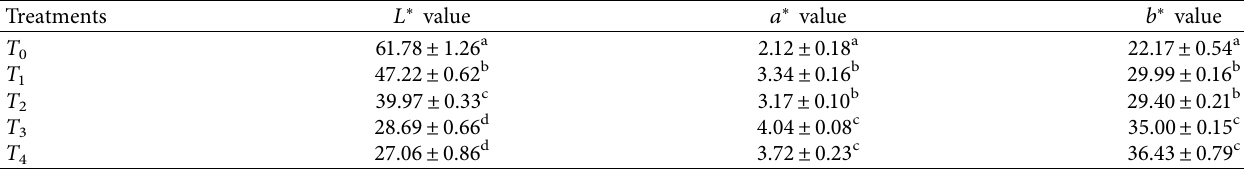
Table 5: Hunter color values of moringa leaf powder (MLP)-supplemented whole wheat four leavened bread.